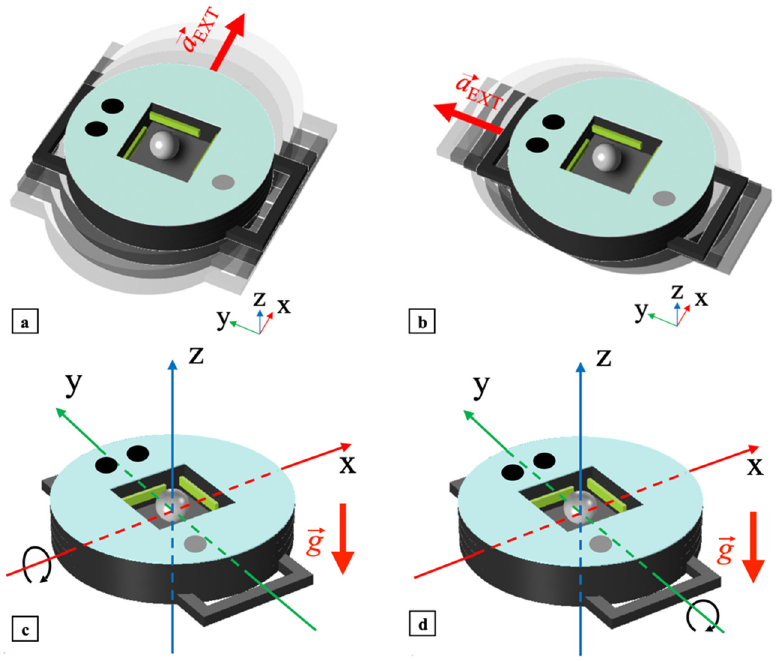
Figure 4. Excitations to which the bi-axial harvester is sensitive: shake applied along the x - ( a ) and y -axis ( b ) and tilt around the x - ( c ) and y -axis ( d ).